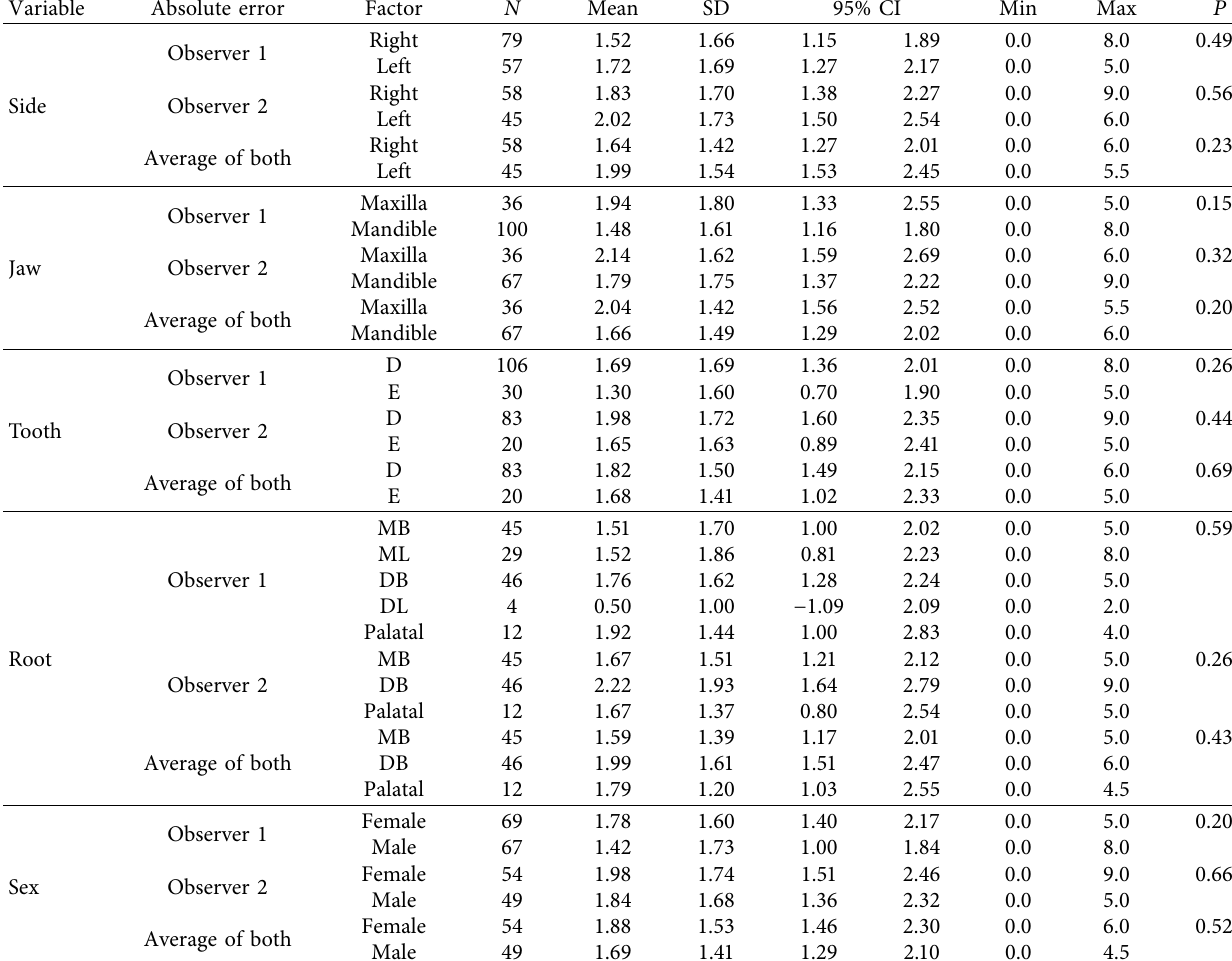
Table 5: Descriptive statistics and 95% CIs for the extents of directionless absolute error (mm) on different sides and in different jaws, teeth, and roots. The P values are calculated using the unpaired t -test and one-way ANOVAs. Variable Absolute error